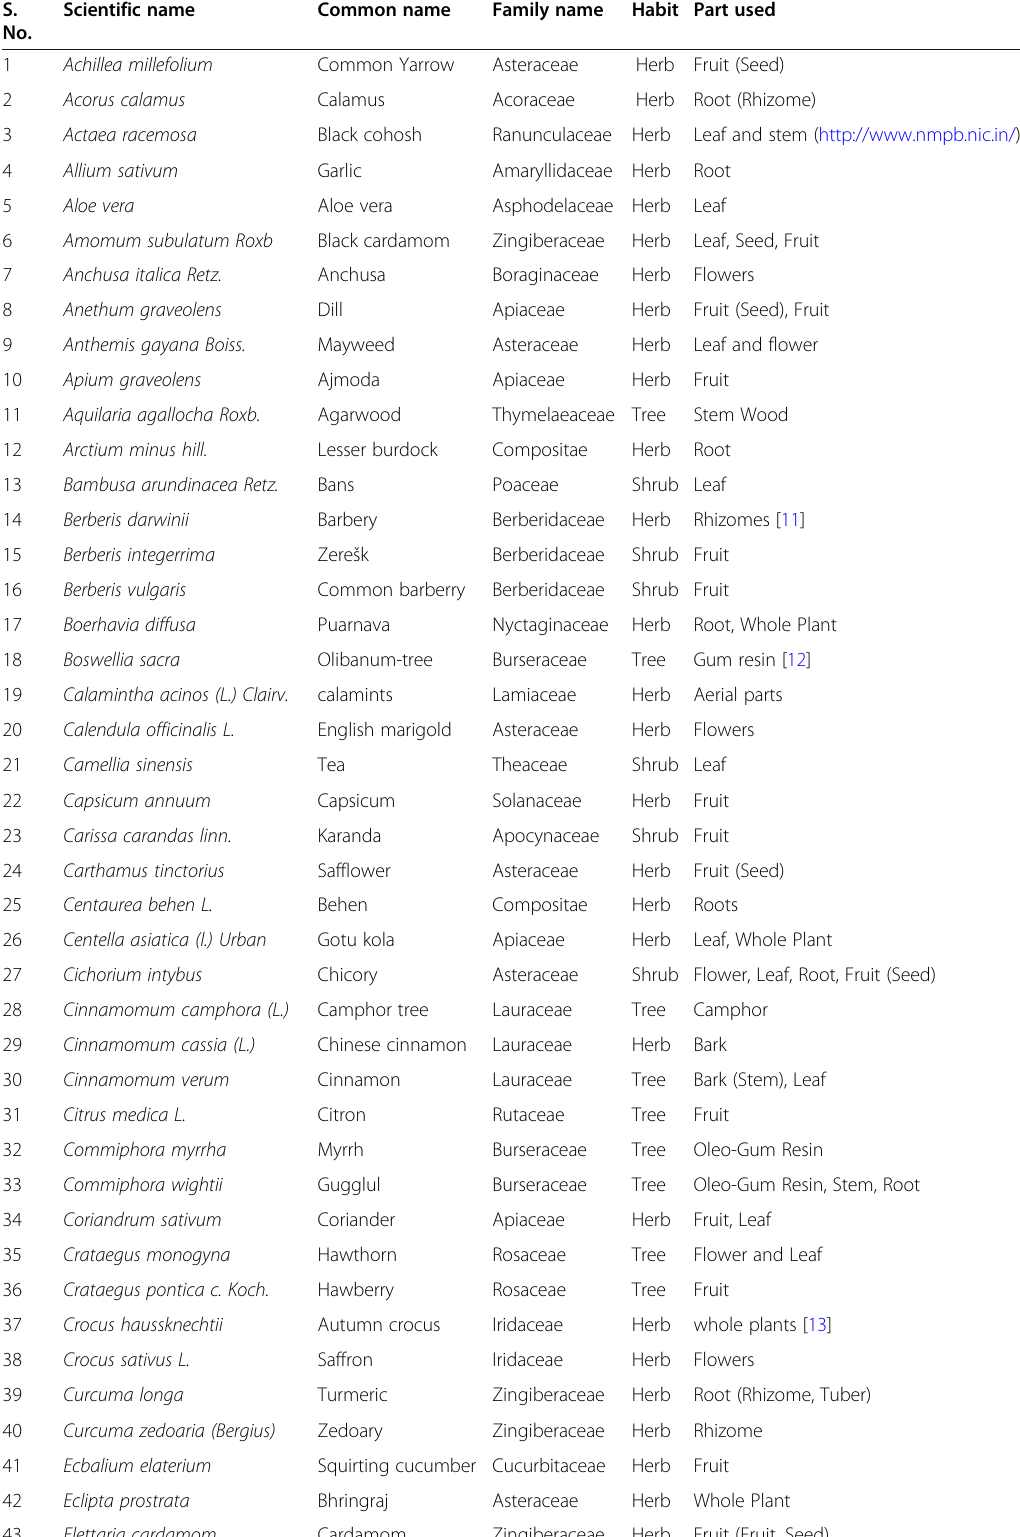
Table 1 List of plants, its habit and parts used for treatment of heart disease S.